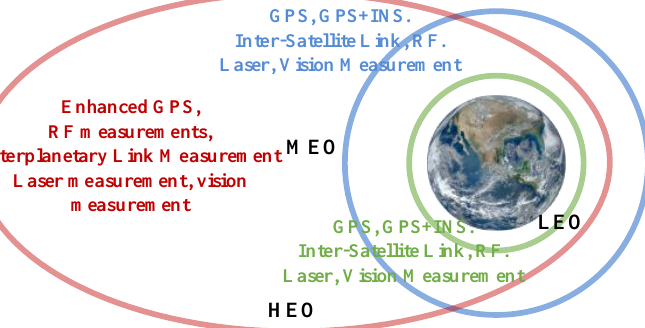
Figure 14. Measurement scheme of the inter-satellite relative state at different orbital heights.